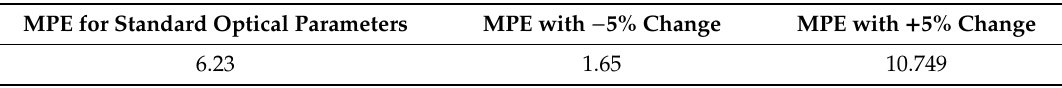
Table 3. Depiction of percentage